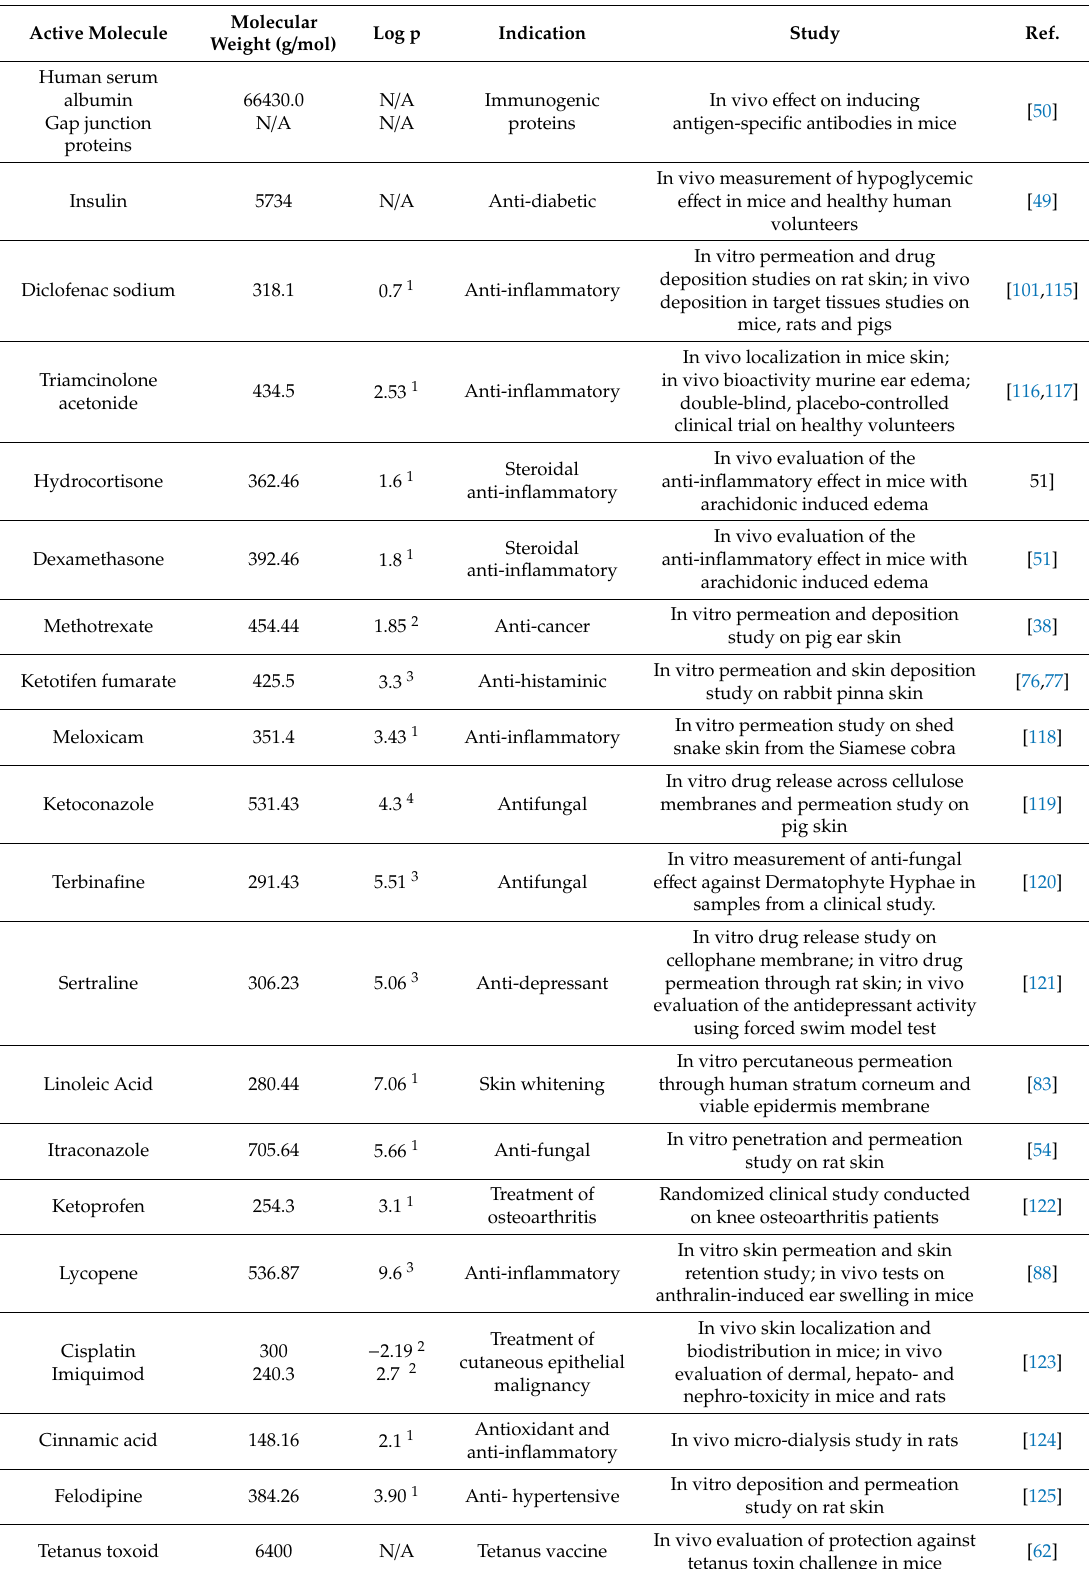
Table 3. Active molecules incorporated in transfersomes and other deformable liposomes investigated for dermal / transdermal administration: in vitro, in vivo preclinical and clinical studies (presented in chronological